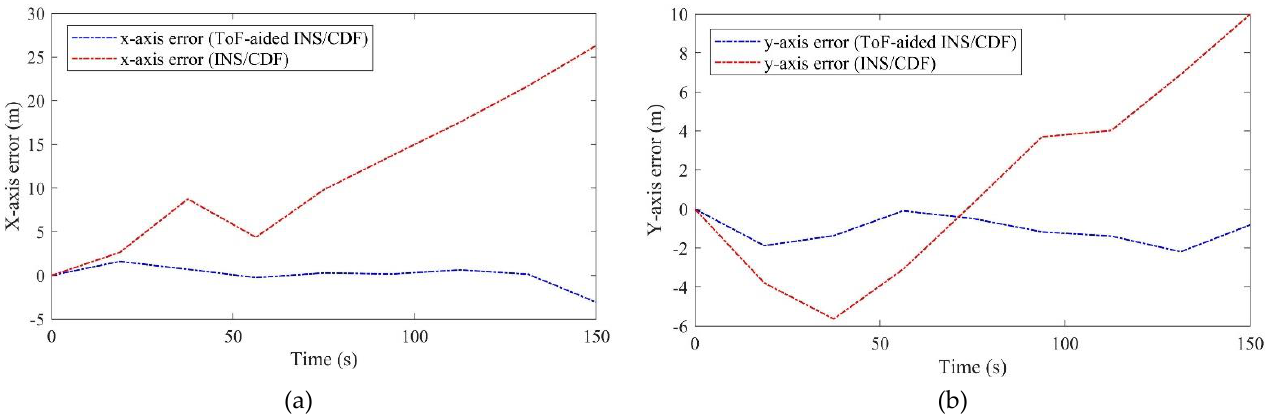
Figure 14. ( a ): The x -axis position error before and after ToF augmentation, ( b ): the y -axis position error before and after ToF augmentation.